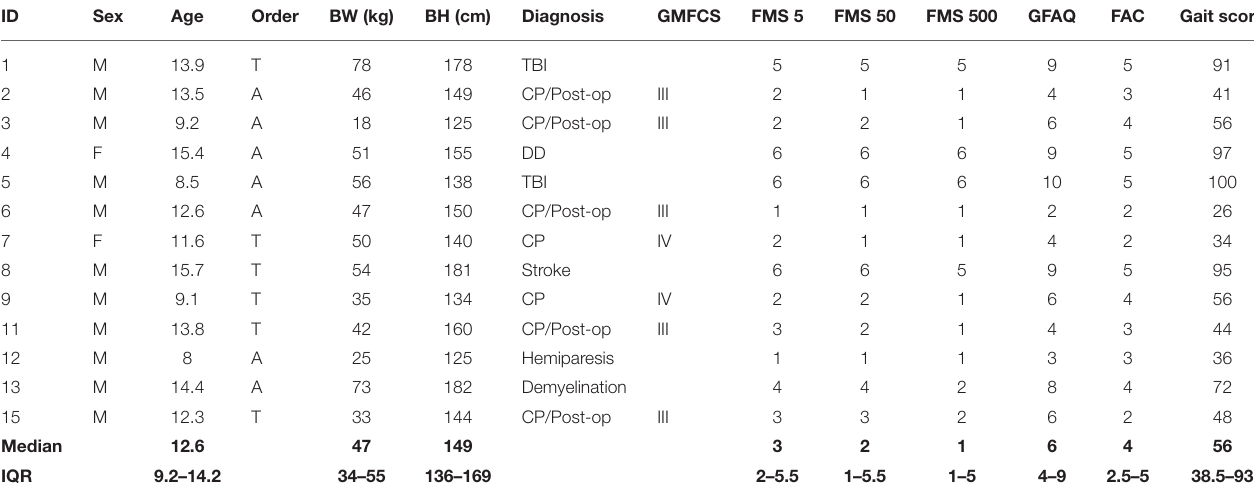
TABLE 1 | Characteristics of the